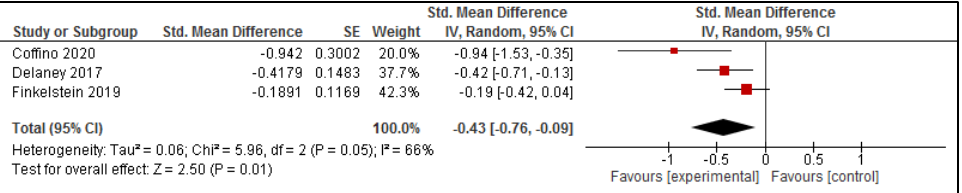
Figure 6. Effect of intervention delivered via online food ordering systems on the Sodium content of purchases.